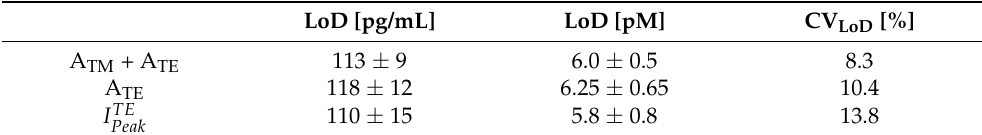
Table 1. LoDs and coefficients of variation for the three analyses represented in Figure